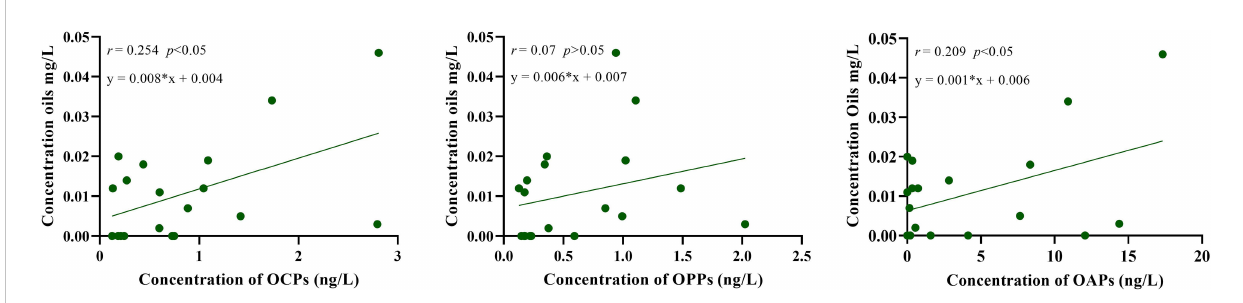
FIGURE 5 Correlation analysis results between pesticides concentration and oils content in